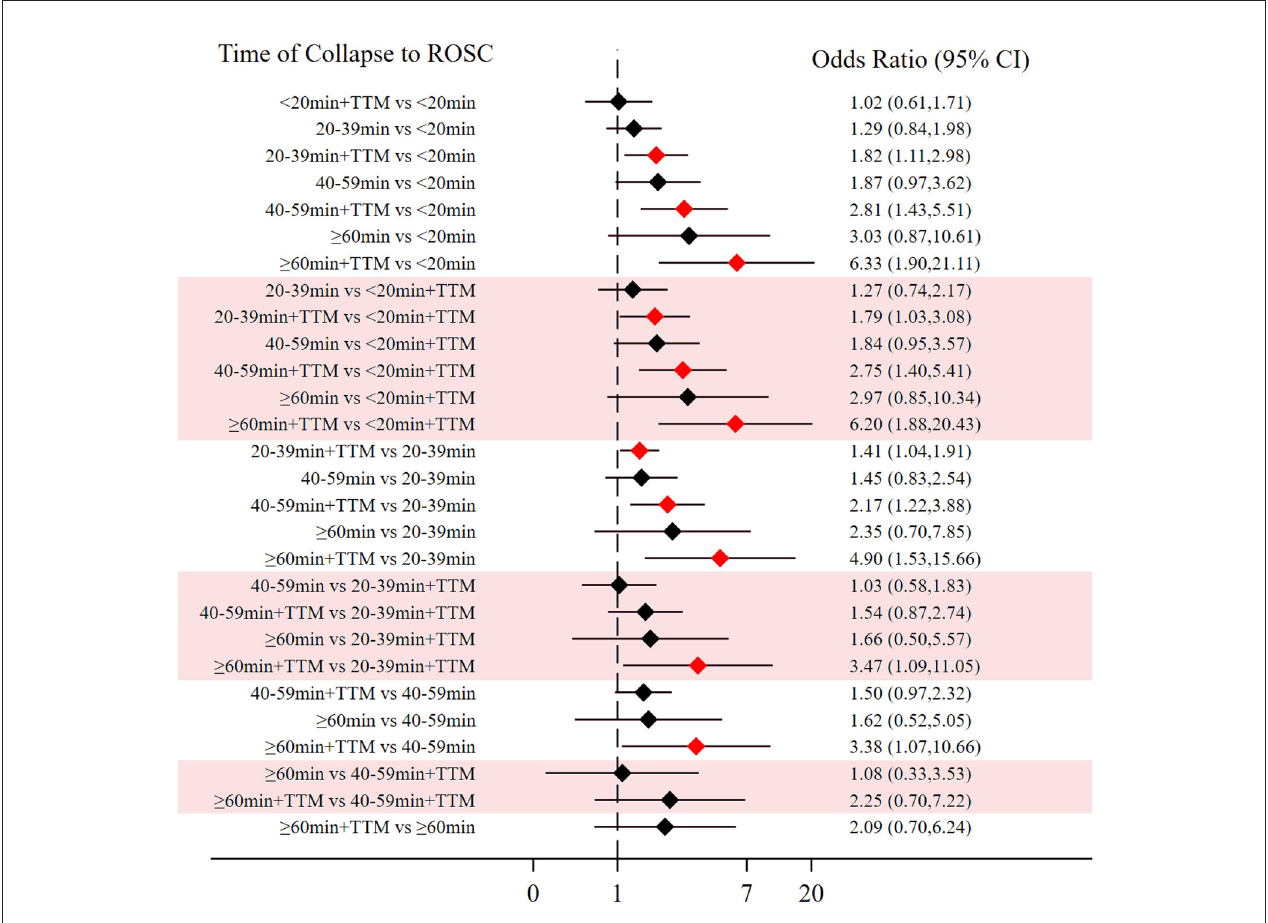
FIGURE 5 | Forest plot for survival (the stepped distributions of each group’s comparison with the same given group are shown in the same background